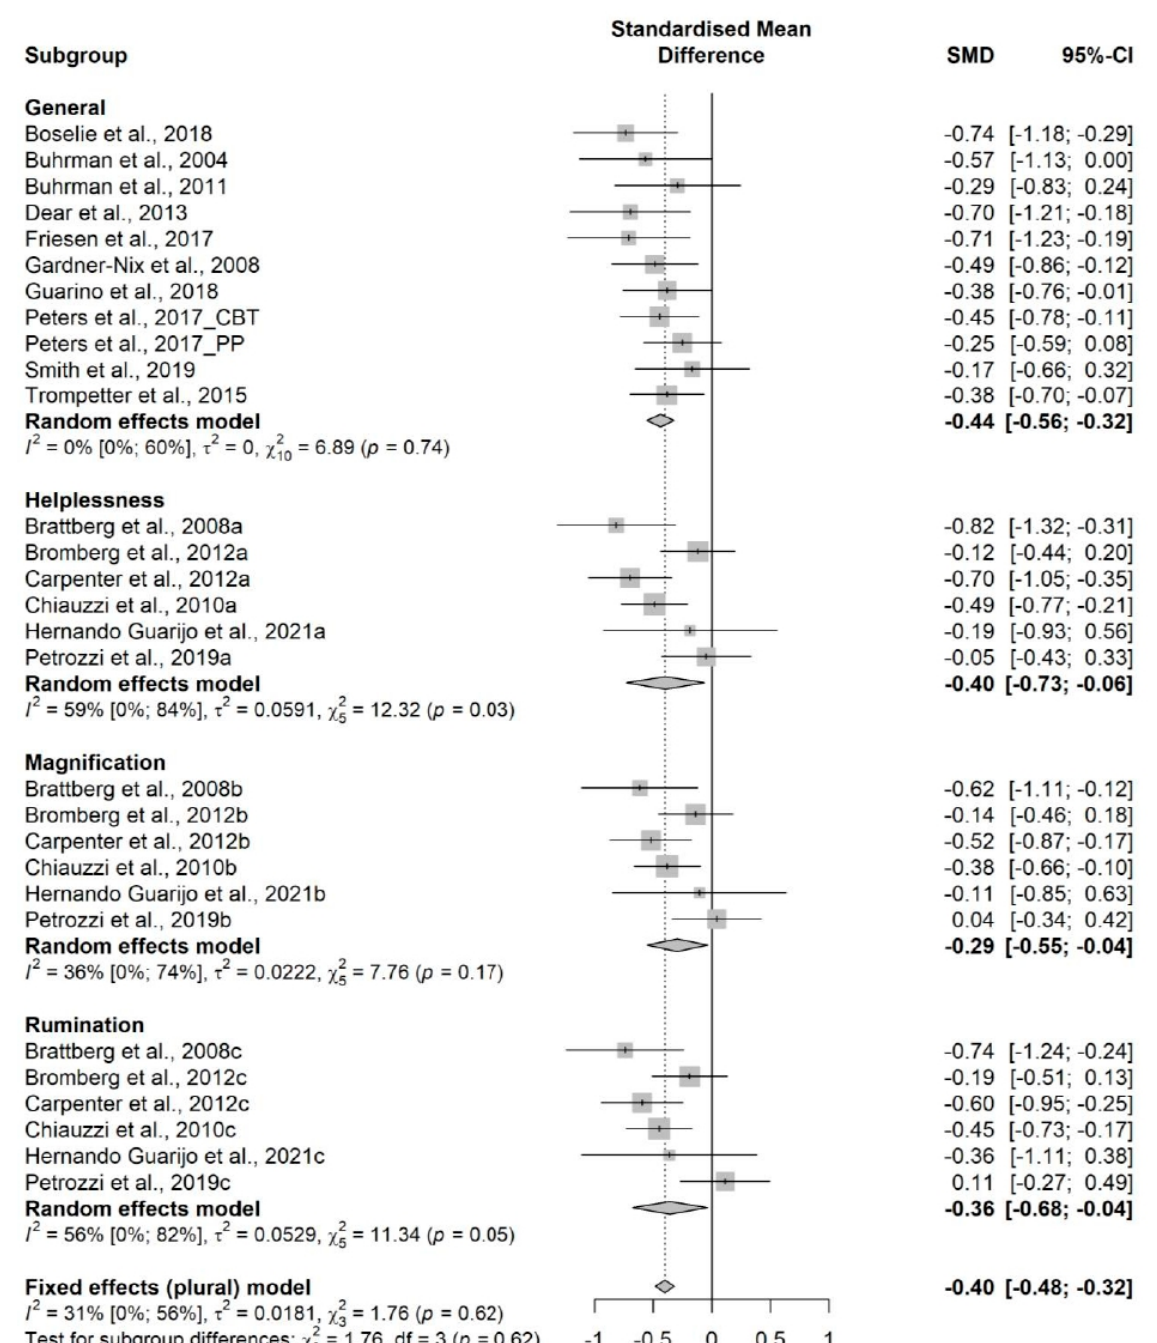
Figure 5. Sensitivity analysis of the catastrophizing variable and the subscales of the pain catastrophizing scale (Helplessness, Magnification and Rumination) for online behavioral techniques against usual care or waiting list. The forest plot summarizes the results of included studies (sample size, mean, standard deviation (SD), standardized mean differences (SMDs), and weight). The small boxes with the squares represent the point estimate of the effect size and sample size. The lines on either side of the box represent a 95% confidence interval (CI).